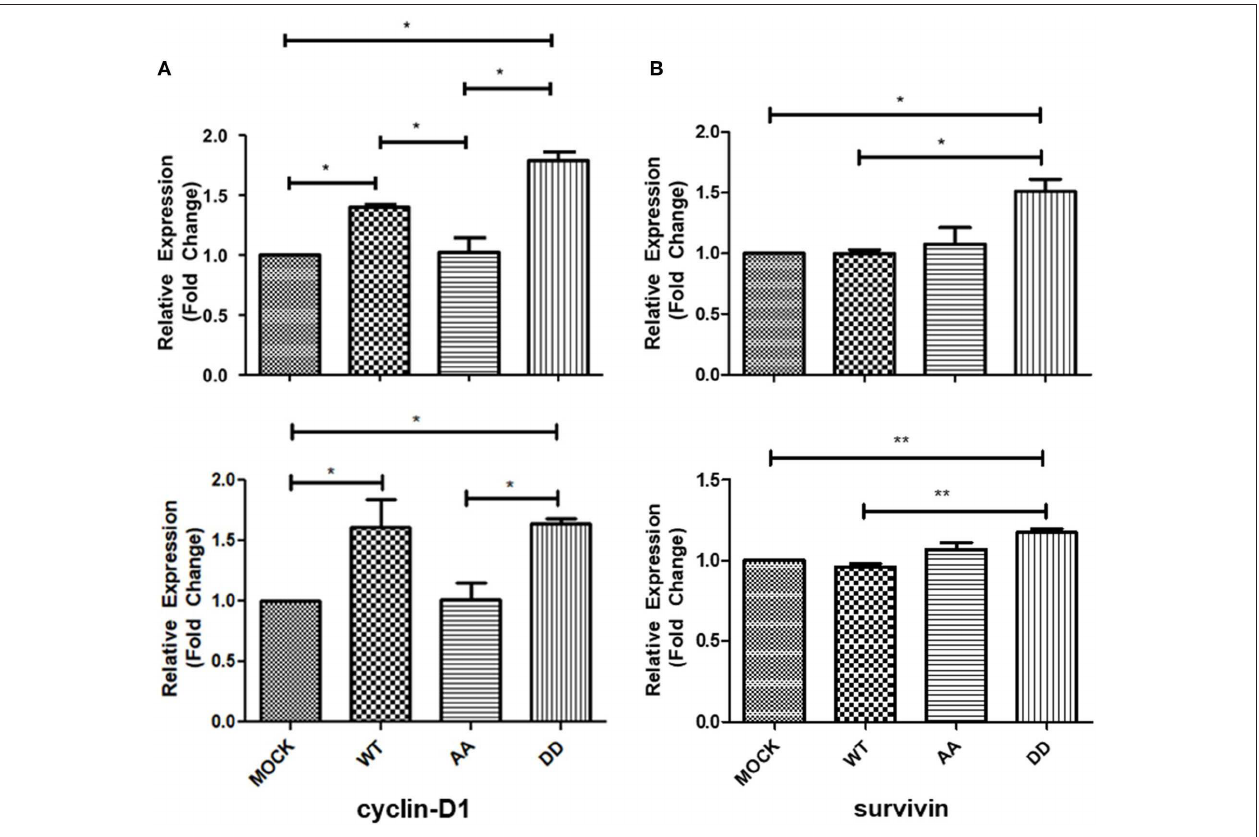
FIGURE 3 | Increased mRNA levels of cyclin-D1 and survivin upon expression of ECE1c DD in CRC cells. HT-29 (upper) and DLD-1 (lower) cells overexpressing Flag-tagged ECE1c WT , ECE1c AA , or ECE1c DD were grown for 24h under normal conditions and mRNA levels of cyclin-D1 (A) and survivin (B) were measured by RT-qPCR. Graphs represent mean ± SEM; * p < 0.05, ** p <